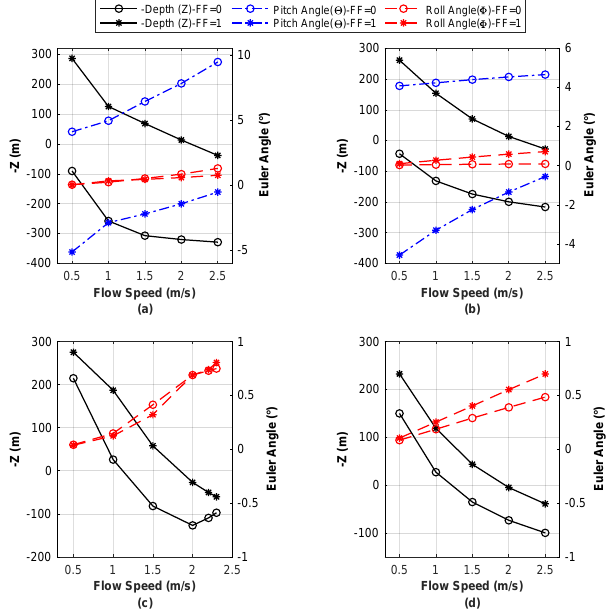
Fig. 4. Operating range assessment for (a) homogeneous flow speeds, (b) shear flow speeds, (c) homogeneous flow speeds ensuring the pitch angle is driven towards zero, and (d) shear flow speed ensuring the pitch angle is driven towards